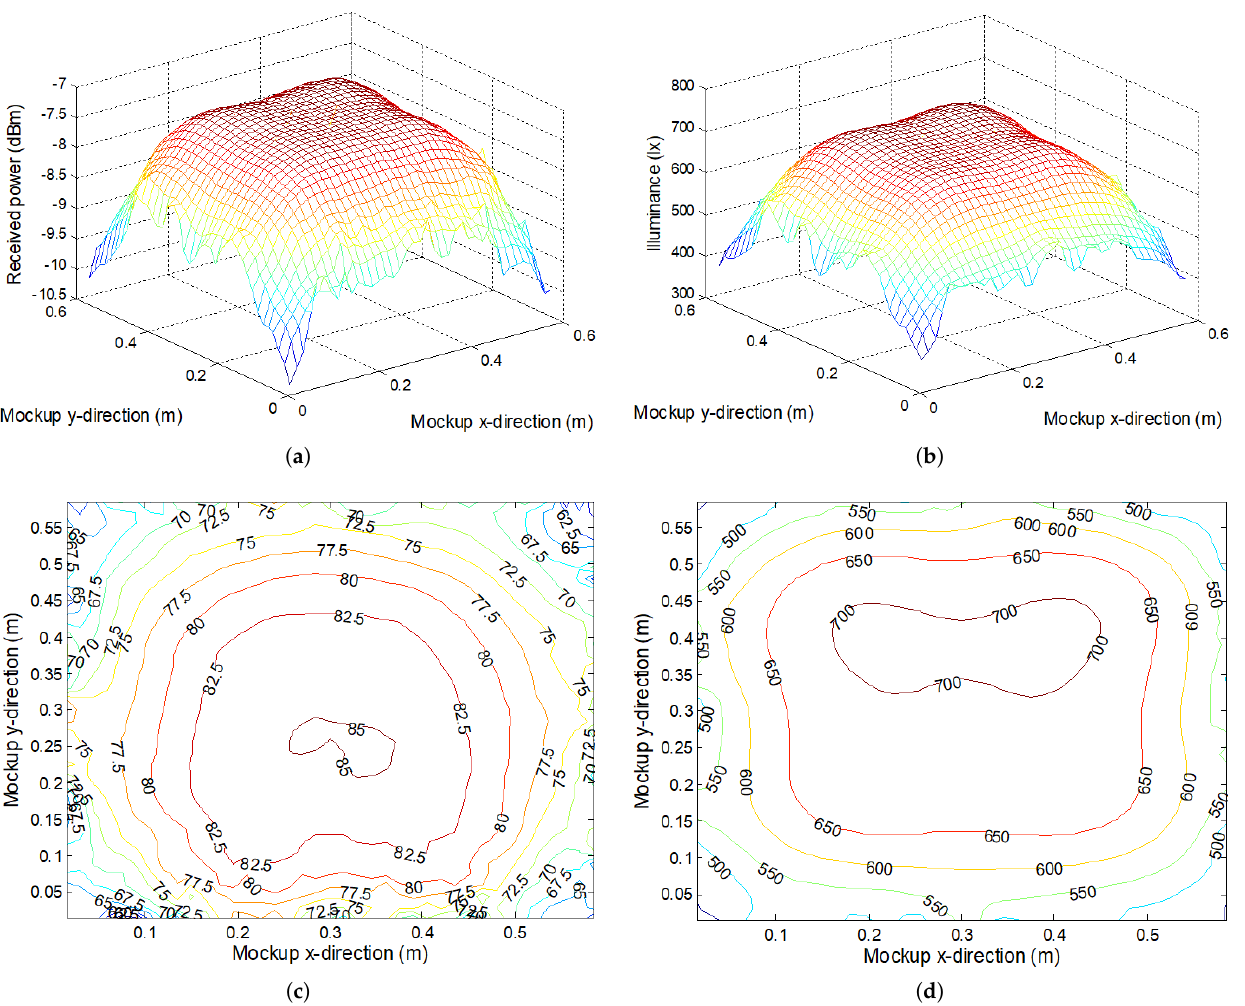
Figure 9. Received power and illuminance at receiver plane for mockup illustrated in Figure 2: ( a ) Power balance. ( b ) Illuminance. ( c ) Contour map of LOS component percentage in the total received power. ( d ) Contour map of illumination